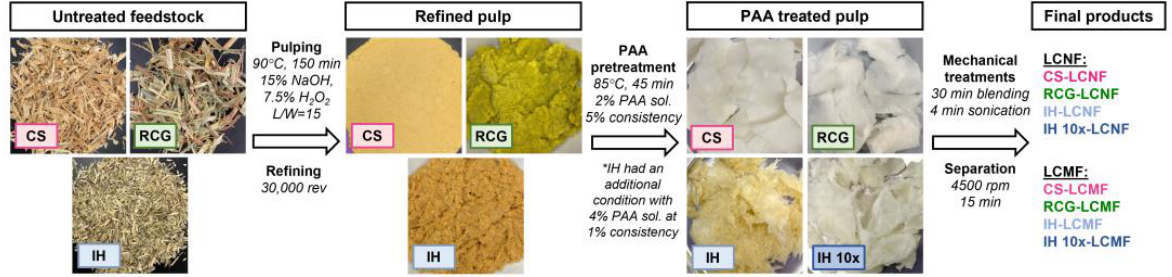
Figure 1. Summary of process steps to produce lignocellulosic nanofibers (LCNF and LCMF) from different biomass feedstocks. The same colors used in this figure to represent the different samples were used throughout the entire work. Particularly for IH biomass, an additional PAA pretreatment was performed at higher PAA loading, producing IH 10x sample.